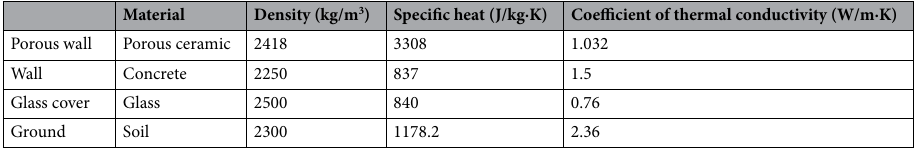
Table 1. Physical parameters of material.